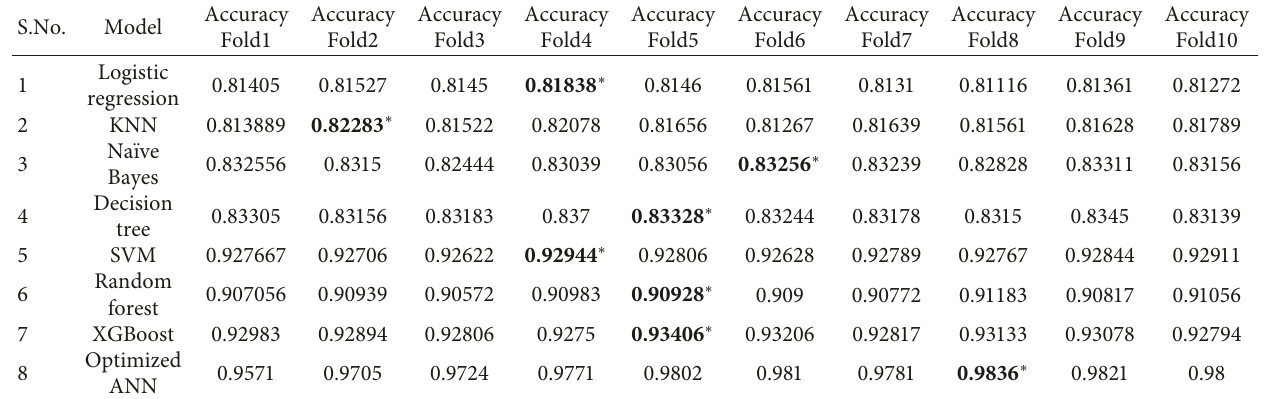
Table 3: Accuracy for every fold using repeated random test-train